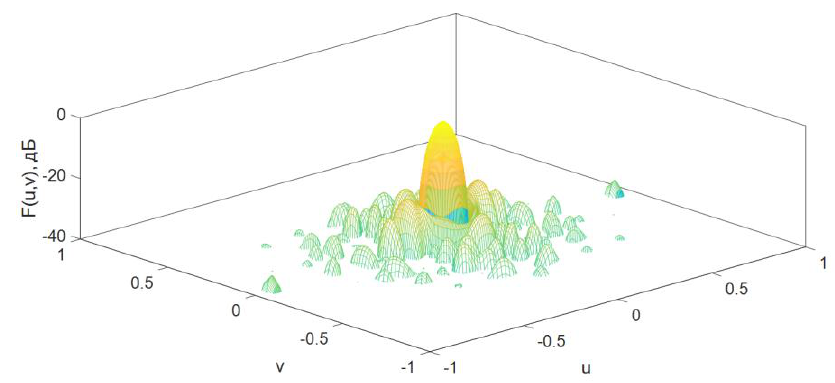
Fig. 6. 3D radiation